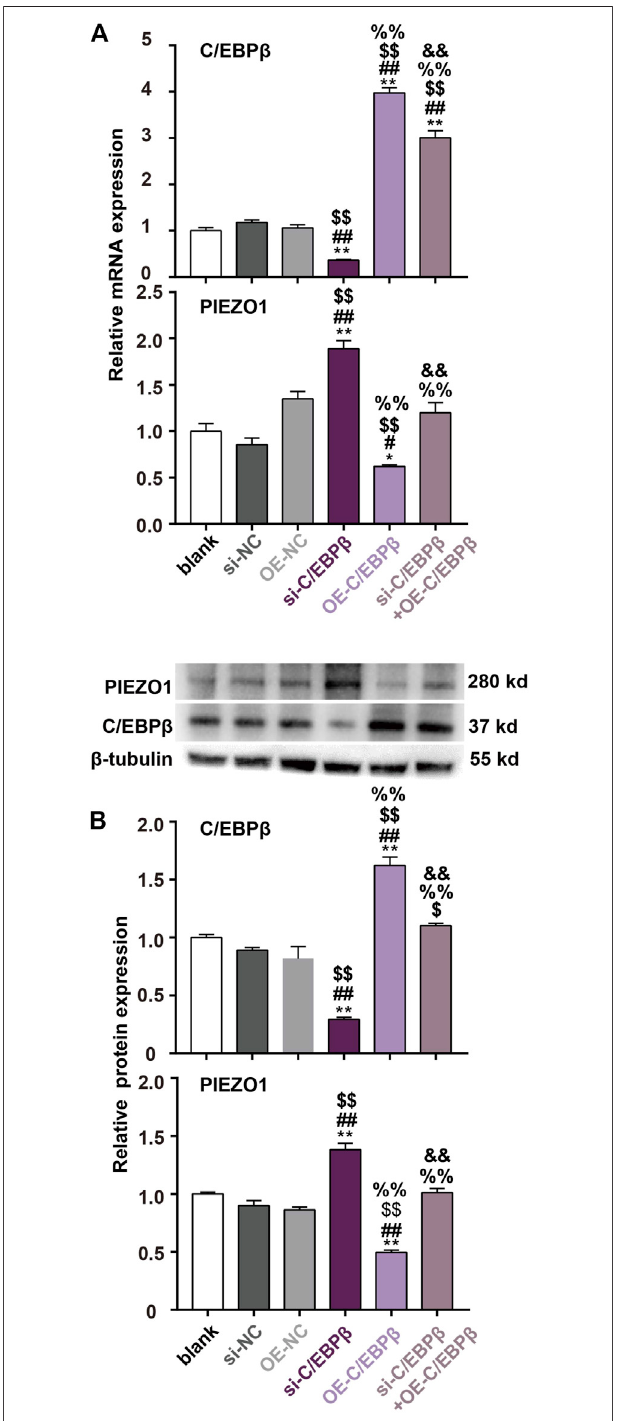
FIGURE 5 | siRNA-resistant C/EBP β plasmid transfection reverse the enhanced PIEZO1 expression by C/EBP β small interfering RNA (si-C/EBP β ). (A) qPCR results showed that the changes of PIEZO1 and C/EBP β mRNA levels after transfection with siRNA-resistant C/EBP β plasmids (OE). (B) Representative Western blotting images and histograms showed that the expression changes of C/EBP β and PIEZO1 protein after transfection with